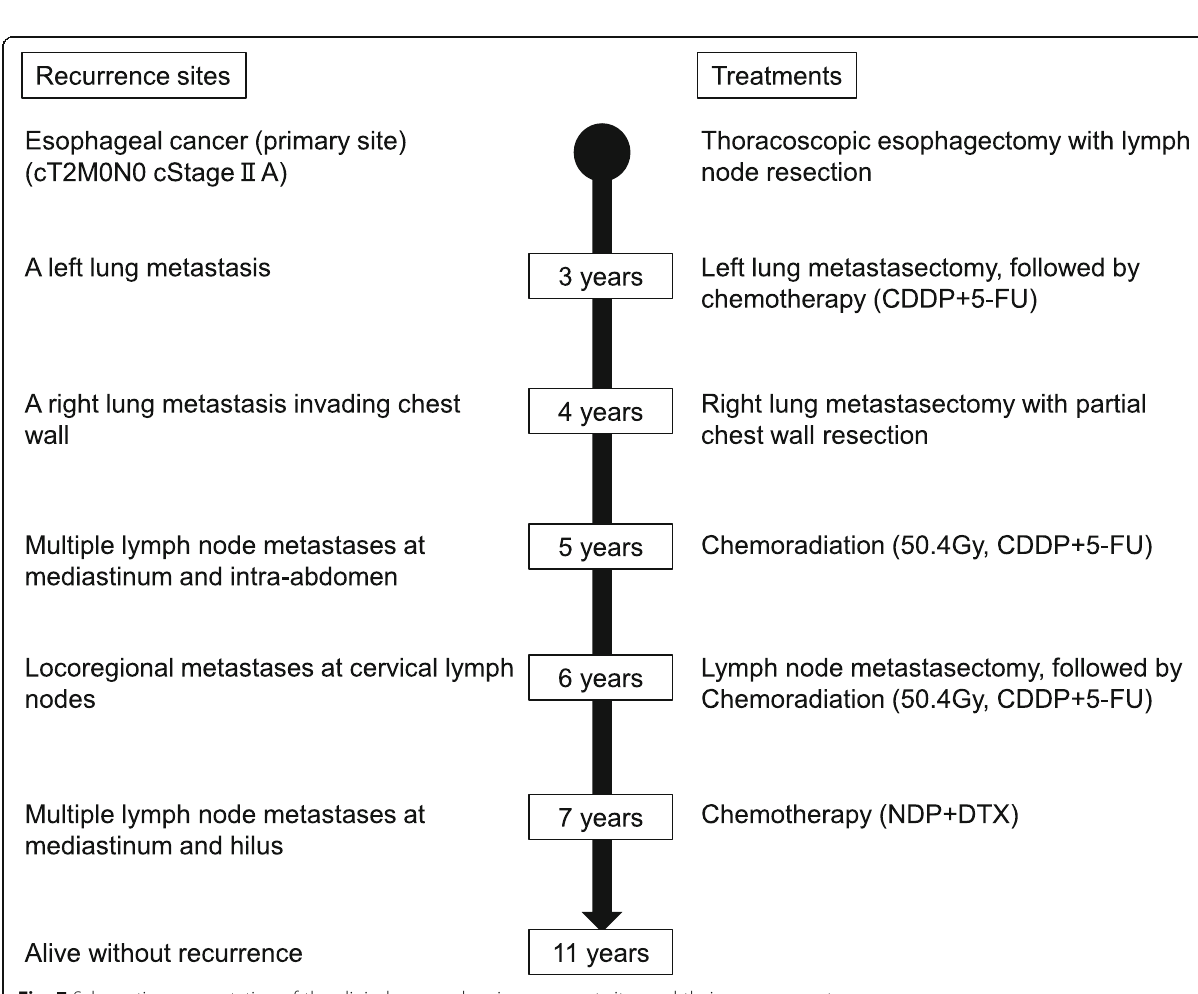
Fig. 7 Schematic representation of the clinical course showing recurrent sites and their